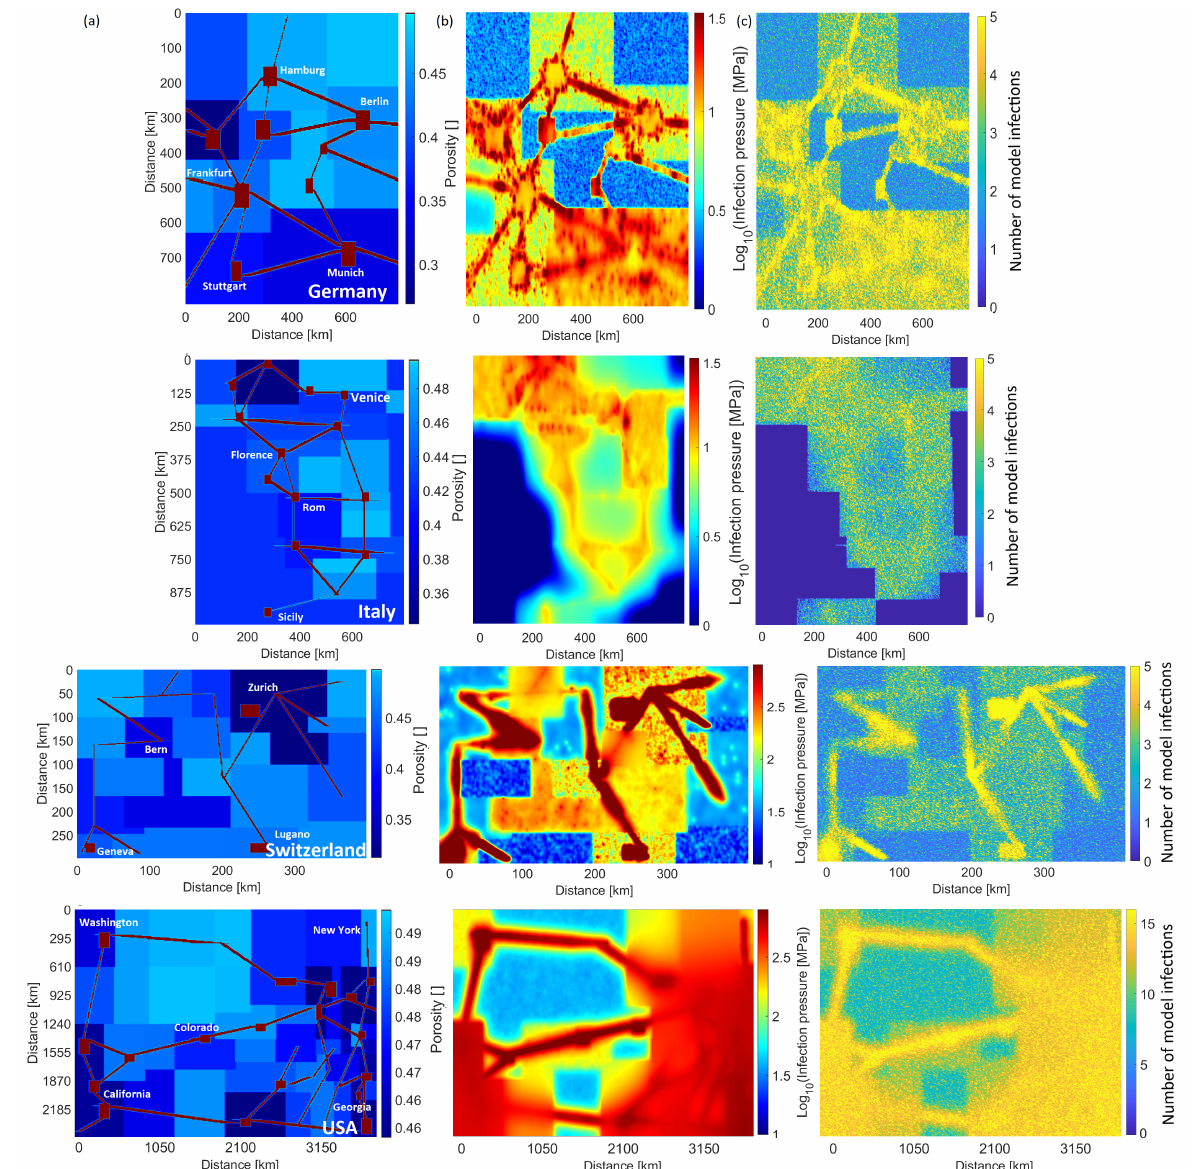
Figure 2. ( a ) Model setup for Germany, Italy, Switzerland, and the USA showing the source locations (red boxes) signifying airports and intercity rail lines (red lines), and the various shades of blue scale with population density reflecting the “porosity” distribution and delineate federal states. ( b ) Calculated infection pressure at the end of the 300 day simulation. Note change in scale bar for each country because of the very large variations in infection pressure. ( c ) The number of repeated infections calculated in the model highlights the regions most affected and shows how elevated infection pressures ( b ) continue to generate model infections. Similar plots for all other cases studied are found in Supplementary